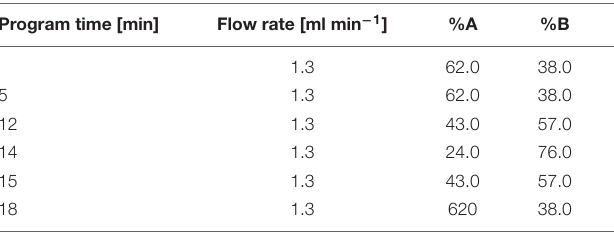
TABLE 3 | Determined parameters of mobile phase gradient conditions in a HPLC separation of FMOC-derivatized amino acids. Program time